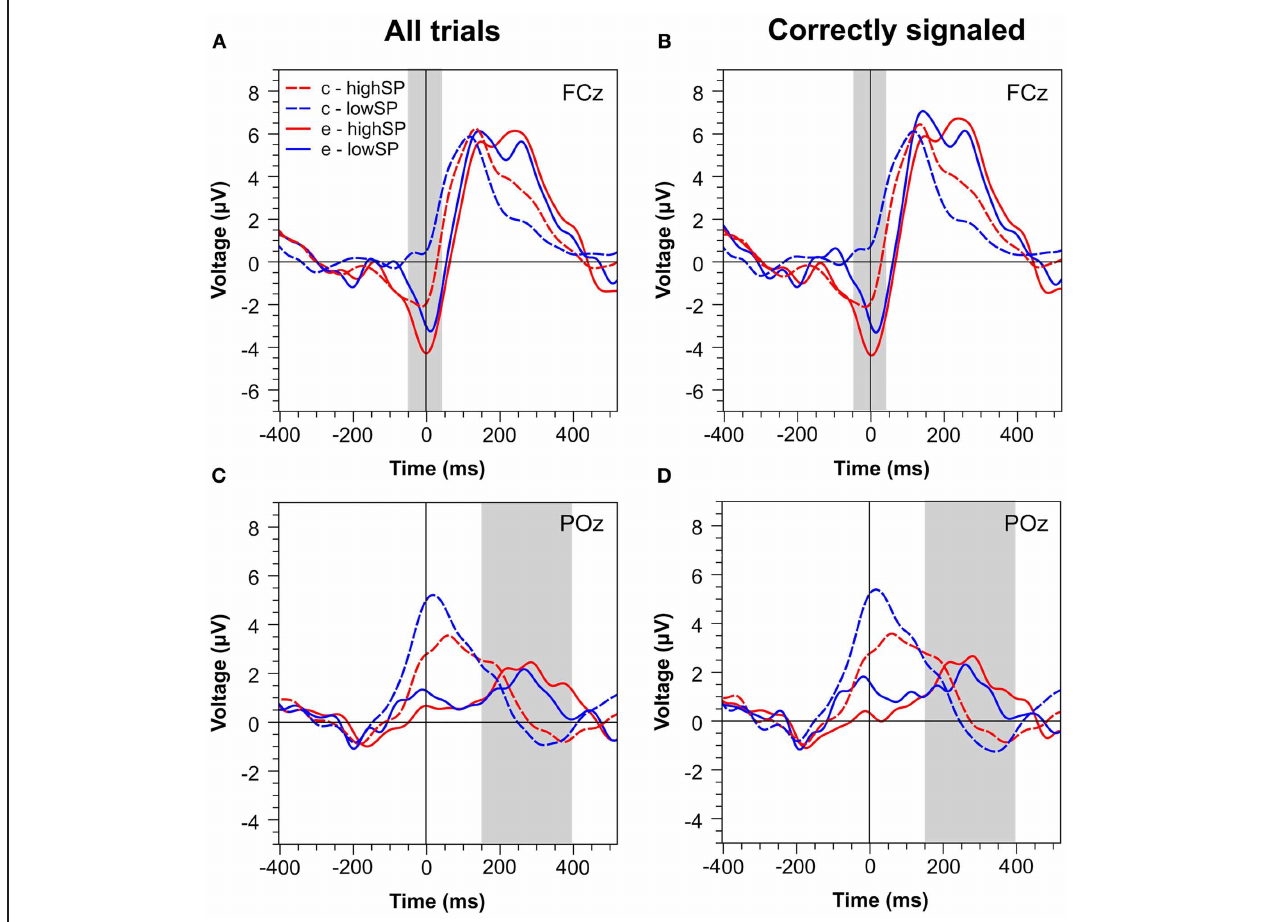
FIGURE 2 | Response-locked ERPs separately for the highSP and lowSP conditions. (A,C) Mean ERP waveforms at electrodes FCz and POz for all errors and correct responses. (B,D) Mean ERP waveforms at electrodes FCz